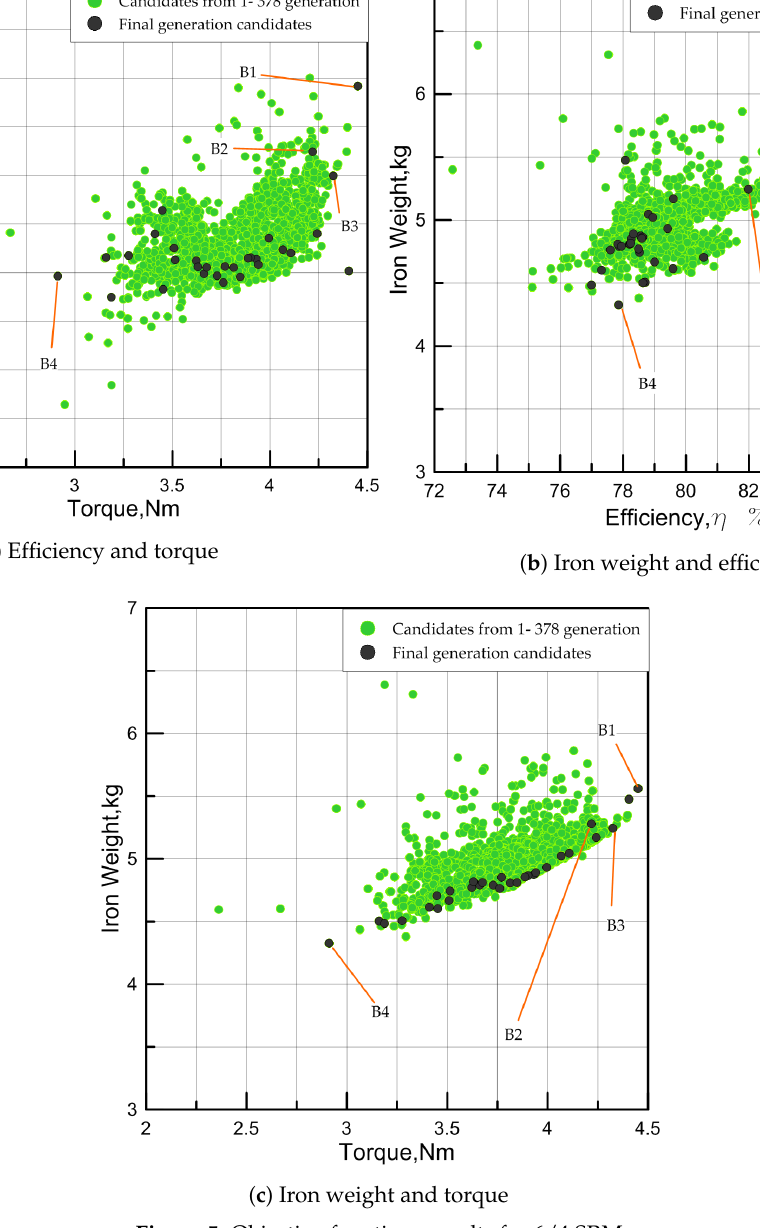
Figure 5. Objective functions results for 6/4